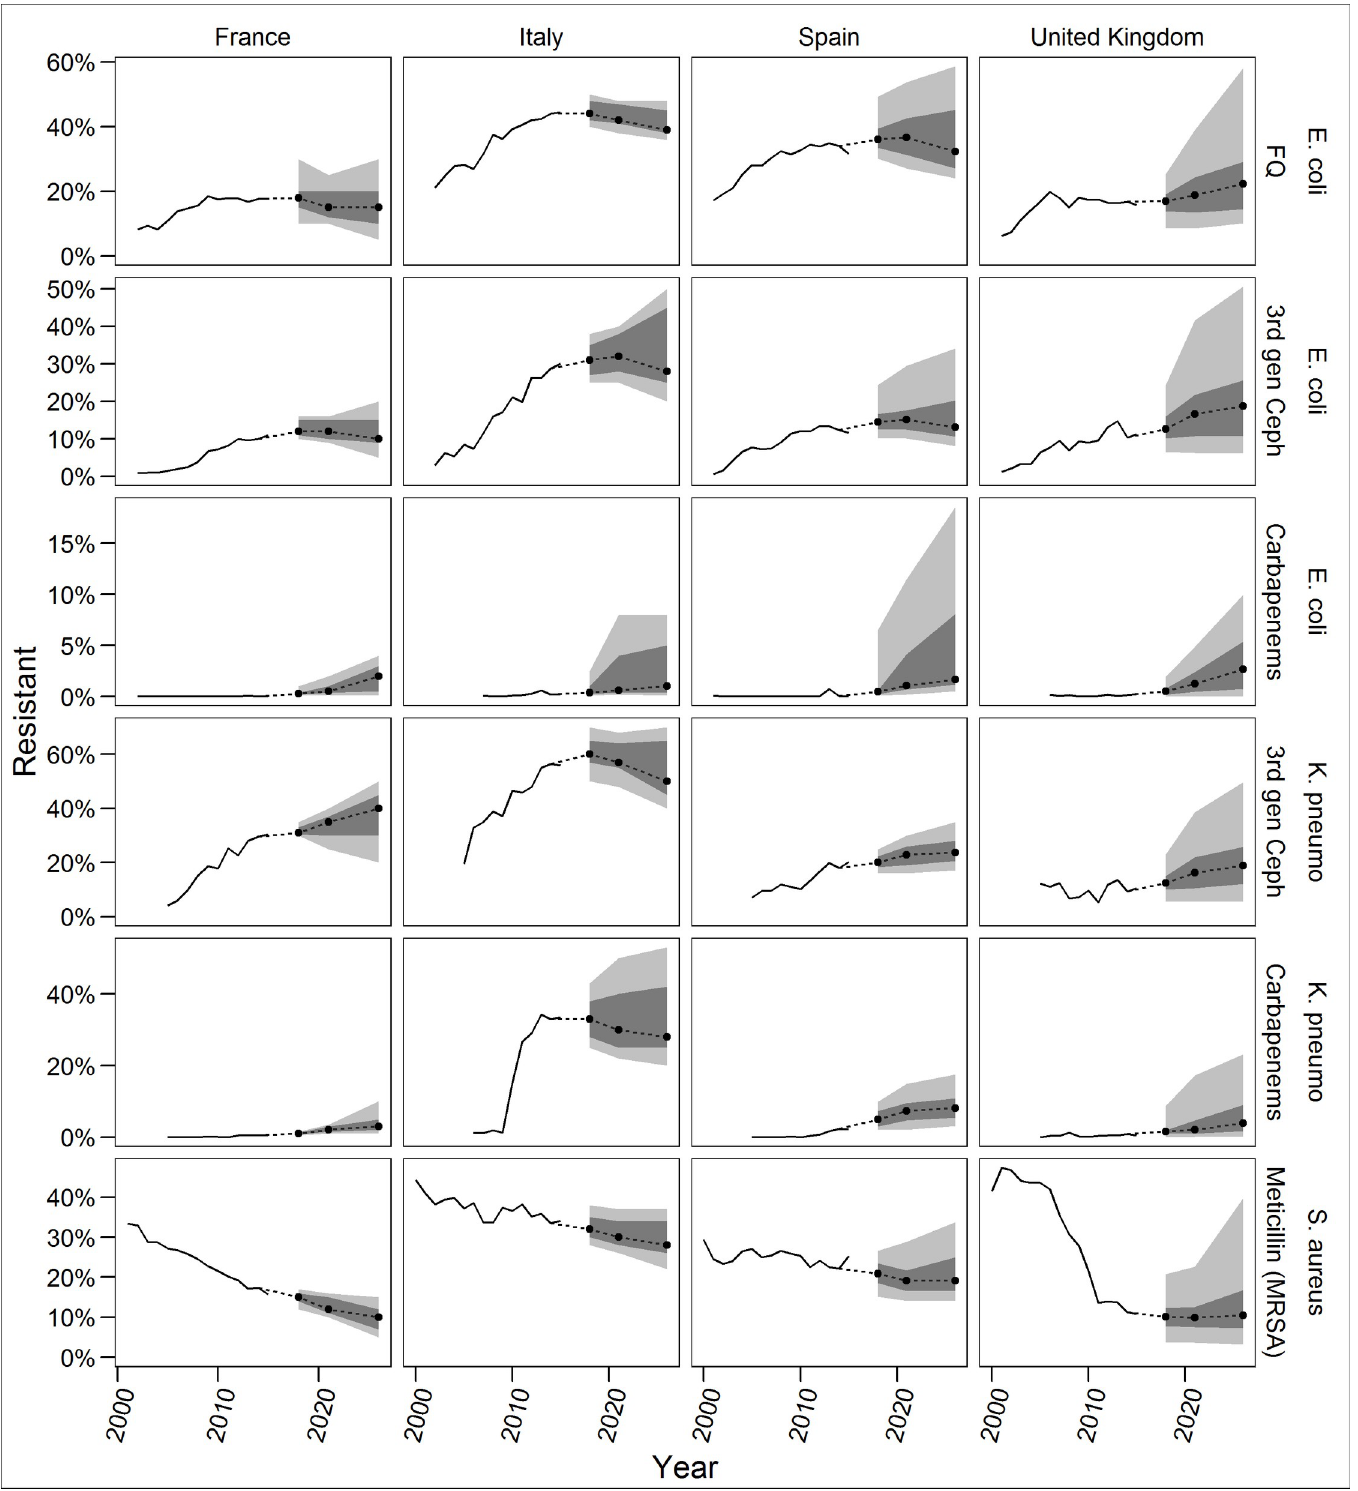
Fig 1. Performance-weight decision maker assessments. Solid lines depict EARS-Net data. Dots indicate the median assessment, dark grey is the 50% credible range, and light grey is the 90% credible range. Experts assessed rates for 2018, 2021, and 2026. Plots linearly extrapolate other future years.